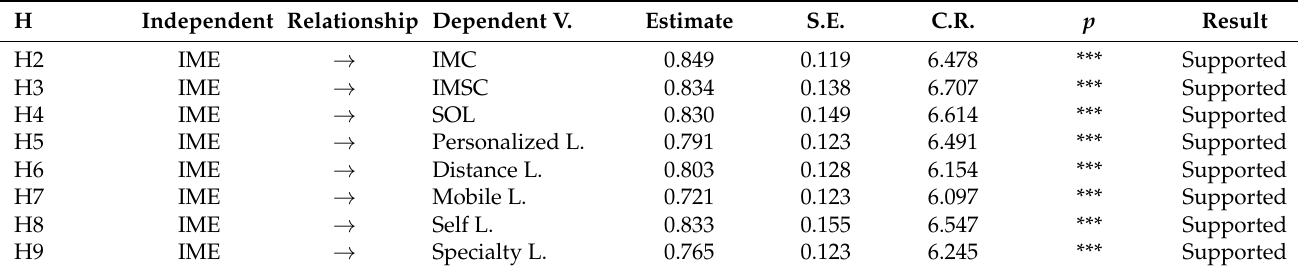
Table 10. Structural models for hypothesis testing